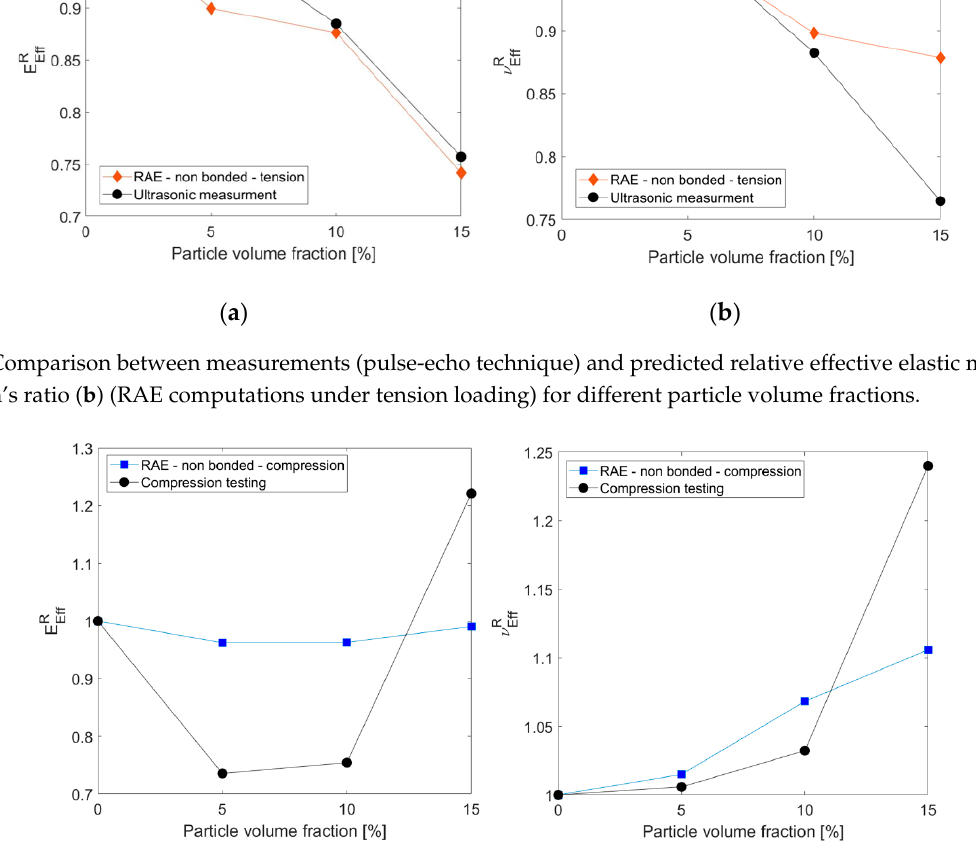
Figure 13. Contact-stress maps of RVE with nonbonded interface conditions for various particle volume fractions.